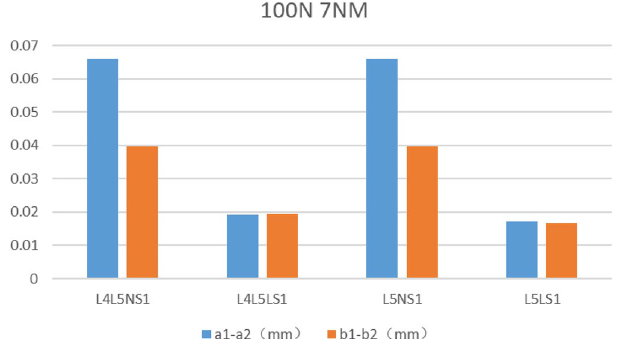
Figure 9. Fracture separation value under 100N slave load and 7Nm torque.